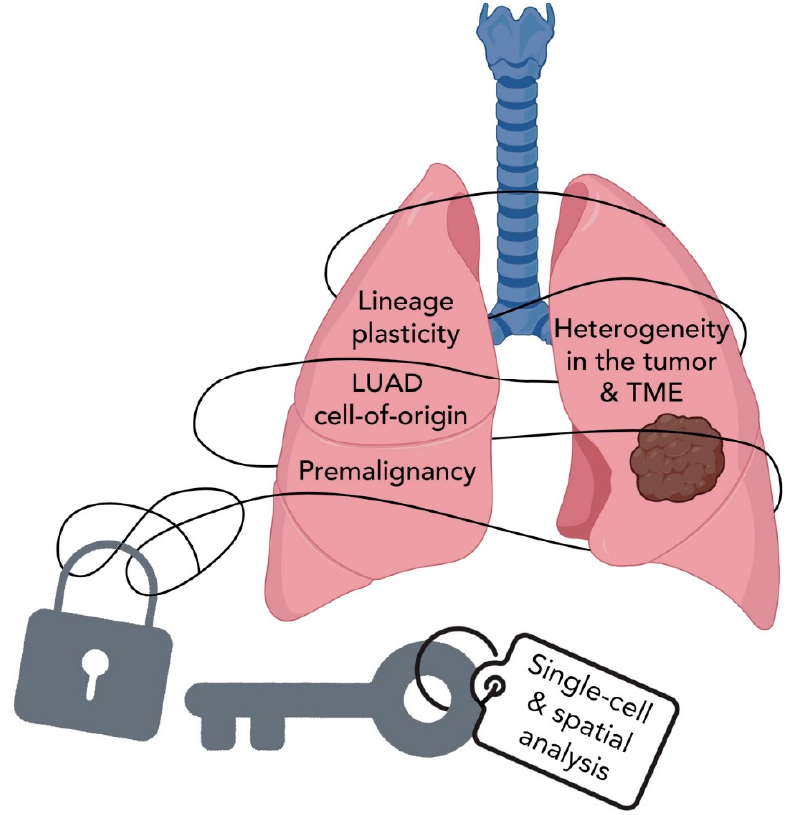
Figure 3. Single-cell RNA sequencing can help unravel the evolution of LUAD. Studying LUAD PMLs and tumor lesions at the single-cell and spatial levels has unlocked novel concepts and intriguing phenomena in the spatiotemporal evolution of the malignancy. These advances continue to elucidate our knowledge of cells-of-origin, lineage plasticity at early and late stages of tumor evolution, and the complexity of heterogeneity within the tumors and in their microenvironments. LUAD; lung adenocarcinoma, TME; tumor microenvironment.